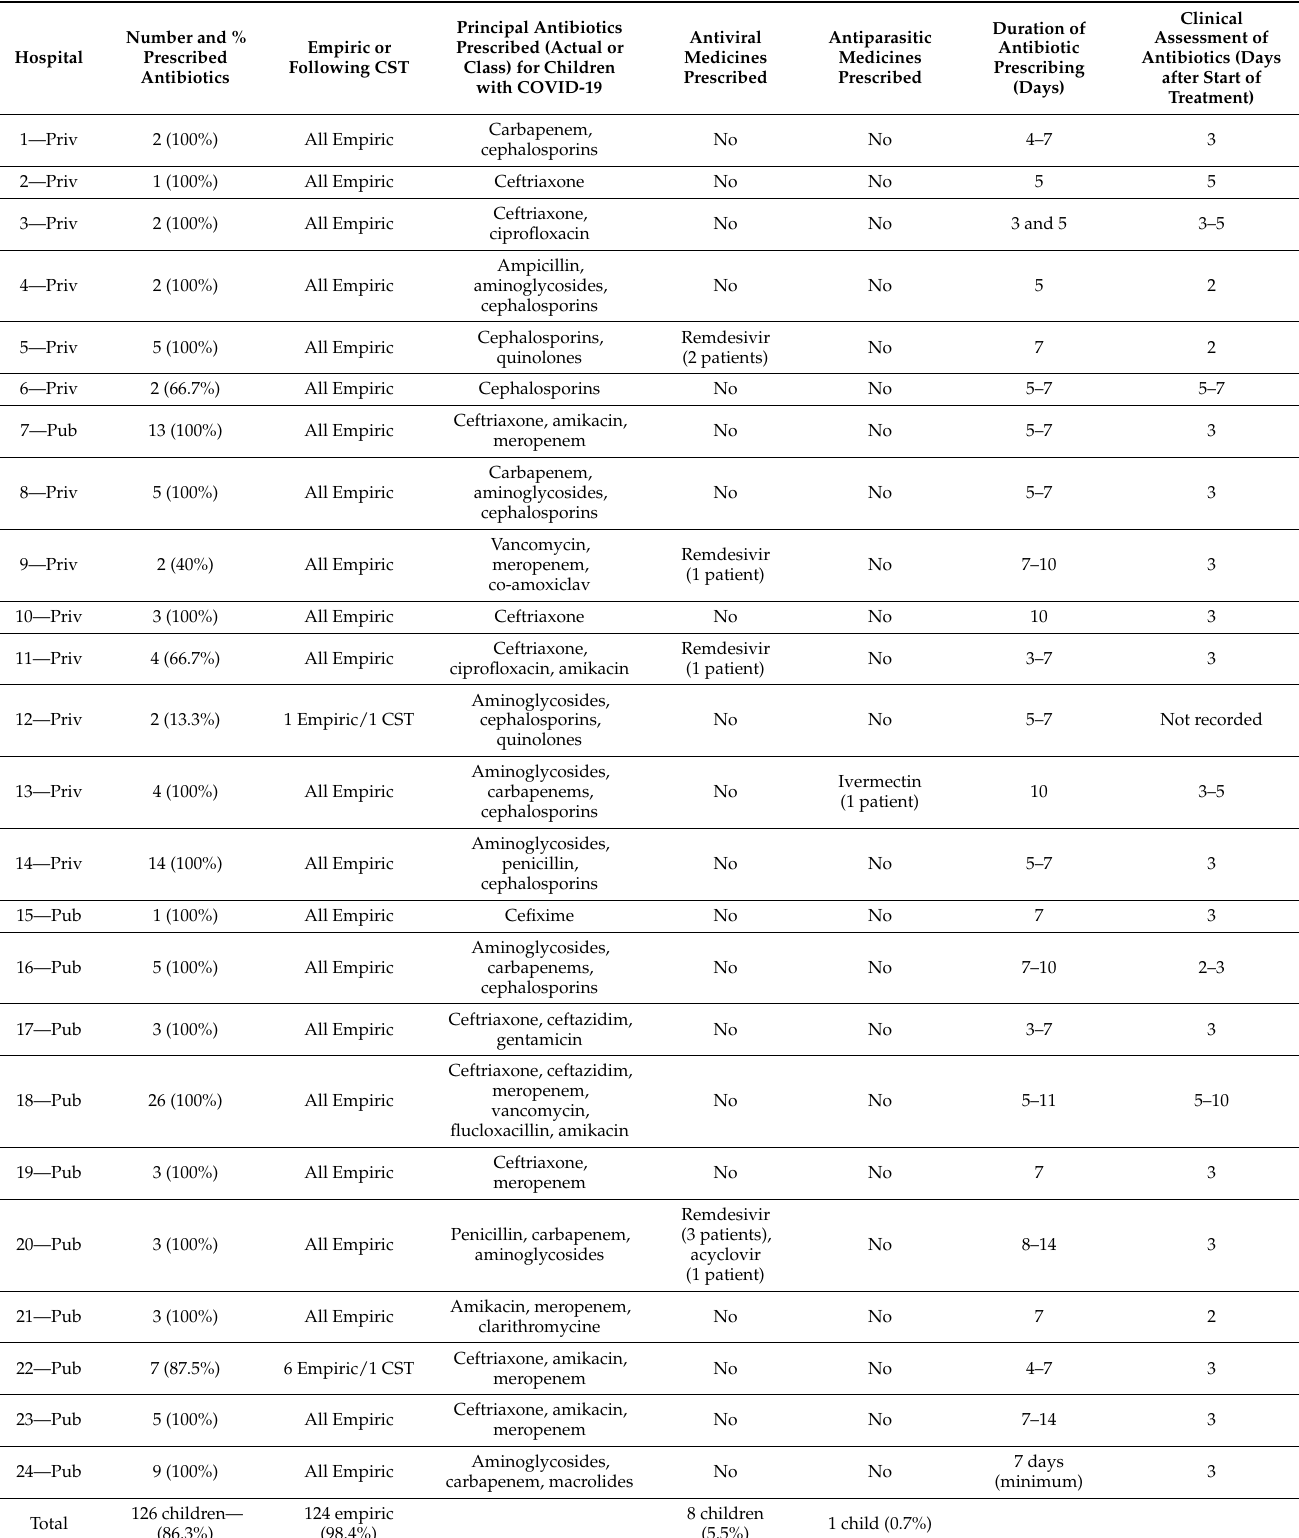
Table 4. Clinical management of children with COVID-19 among the 24